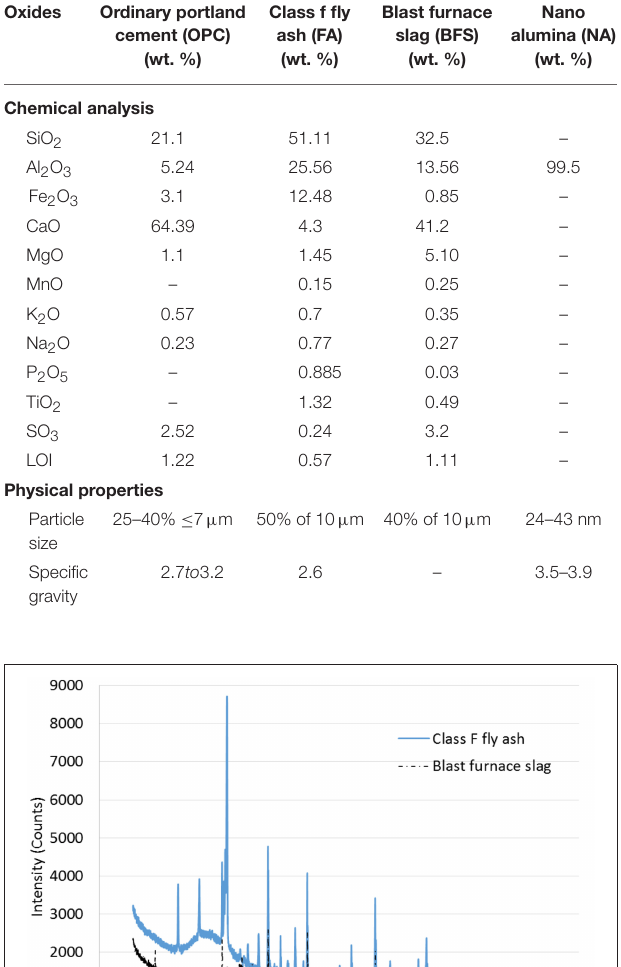
TABLE 1 | Physical properties and chemical analysis of OPC, BFS, FA, and NA. Oxides Ordinary portland cement (OPC)